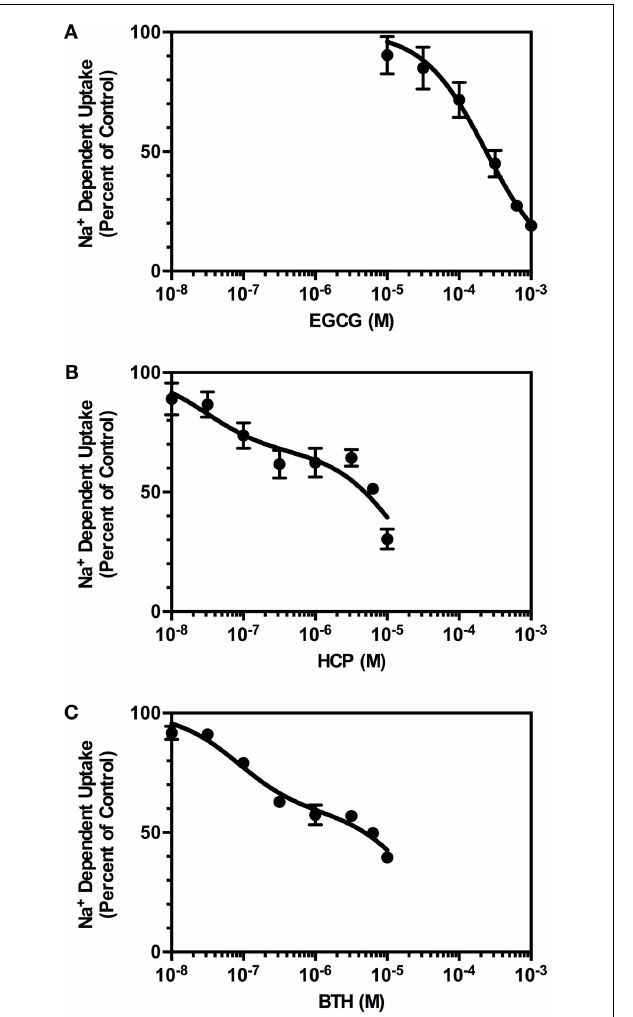
FIGURE 4 | Eadie–Hofstee plot of the concentration-dependence of L -[ 3 H]-glutamate transport in crude membranes (P2) prepared from cortex with no treatment (control; circle), 0.1 µ M HCP (square), or 6.0 µ M HCP (triangle) . Uptake was determined as described in Section “Materials and Methods.” Data presented are from a single experiment that has been repeated in four independent experiments with similar results.The K m values for transport were 5.7 ± 0.3 µ M in vehicle control, 5.4 ± 0.4 µ M in the presence of 0.1 µ M HCP, and 4.2 ± 1.0 µ M in the presence of 6.0 µ M HCP.The V max values for transport were 1.6 ± 0.4 (nmol/mg protein/min) for vehicle control, 1.2 ± 0.4 in the presence of 0.1 µ M HCP, and 0.7 ± 0.1 in the presence of 6.0 µ M HCP.The K m or V max values were normalized to vehicle controls for each experiment (set to 100%) and compared to those observed in the presence of HCP. HCP had no significant effect on K m value, but significantly reduced the V max value at either 0.1 µ M ( p < 0.01) or 6 µ M ( p <